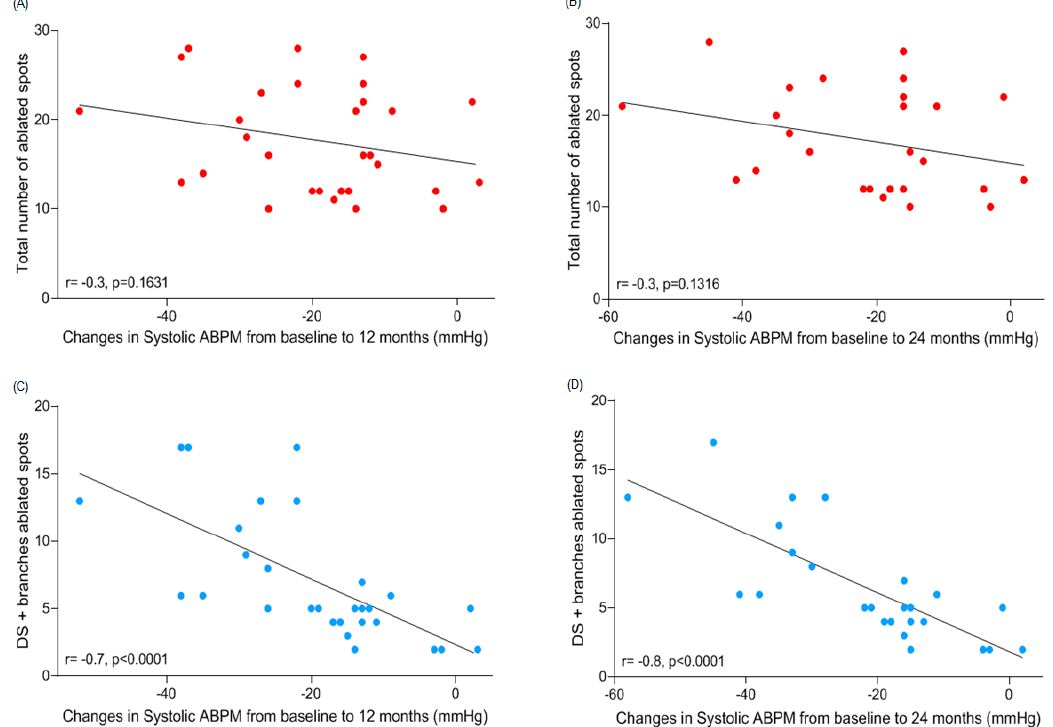
Figure 3. Correlations between change from baseline to 12 and 24 months follow-up in ambulatory systolic blood pressure after renal denervation and ( A , B ) number of ablated spots in total (red dots) and ( C , D ) distal segment summed to branches (blue dots) of renal arteries. ABPM = ambulatory blood pressure monitoring. DS = distal segment. Correlation for the number of treatments performed in the distal segment and branches were significant at both time points.